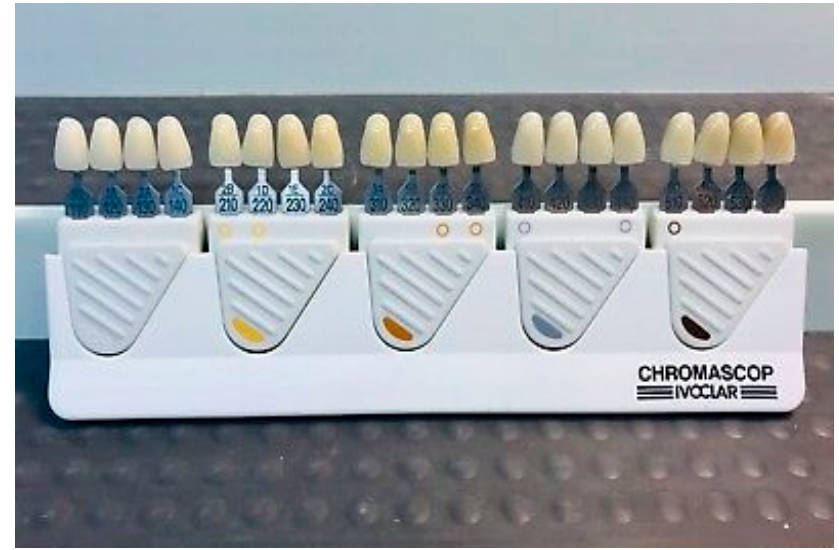
Figure 5. Chromascop Shade Guide.